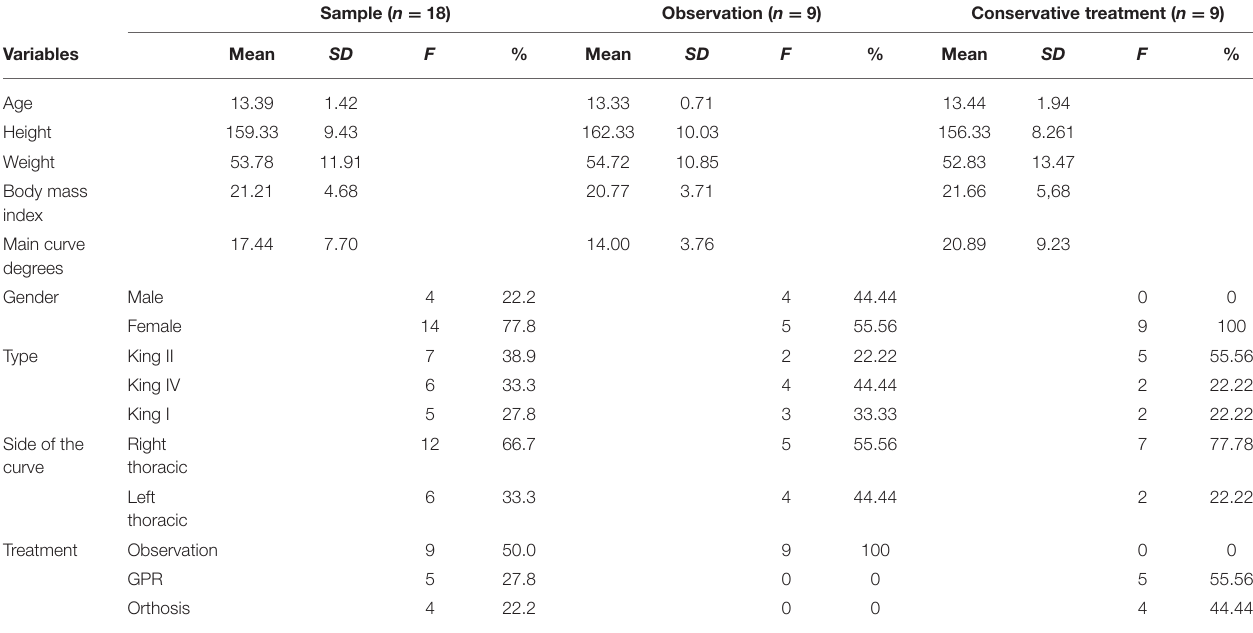
TABLE 1 | Sociodemographic characteristics of the study sample. Sample ( n = 18) Observation ( n = 9) Conservative treatment ( n =